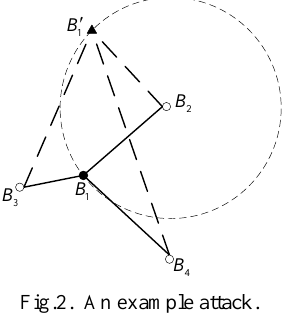
Fig.2. An example attack.